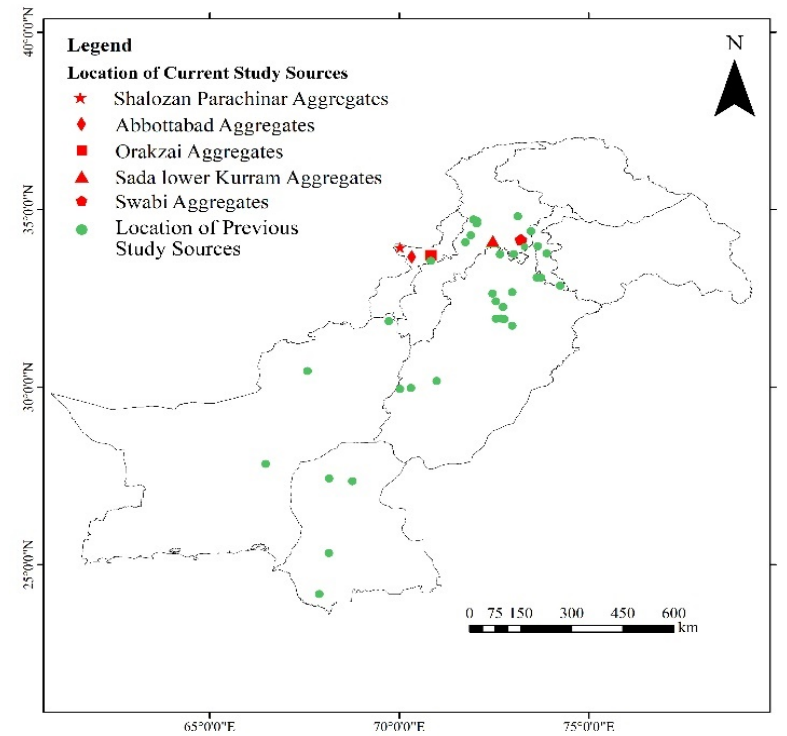
Figure 1. Location of current study aggregates in comparison with aggregates reported in previous studies.